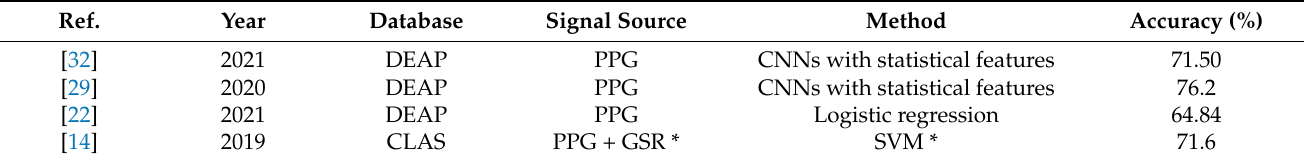
Table 9. Arousal classification accuracies in previous studies.